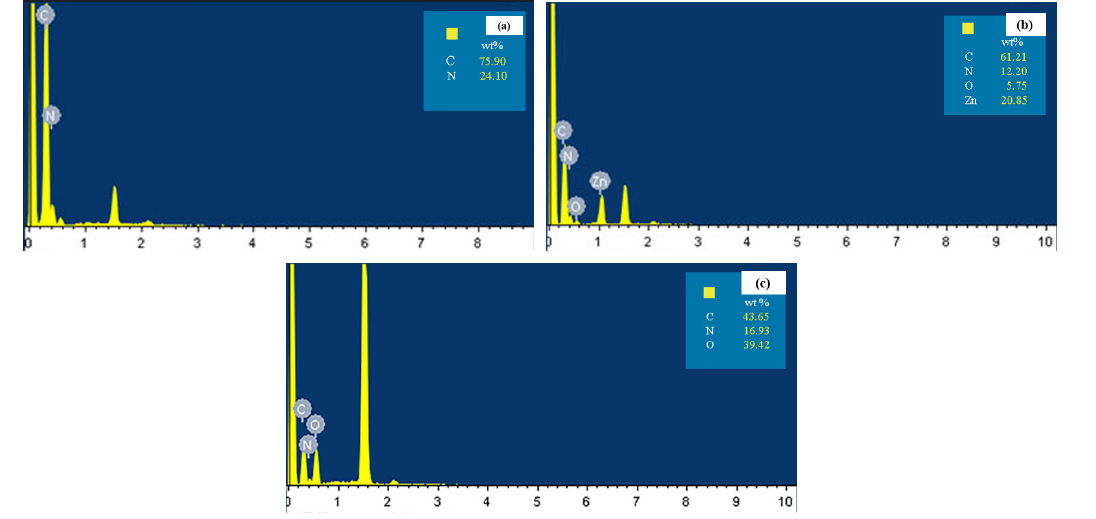
Figure 3. EDS spectra of the original PAN electrospun nanofiber membrane ( a ), ZIF−8@PAN nanofiber membrane ( b ), and the carbonized ZIF−8@PAN nanofiber membrane ( c ).